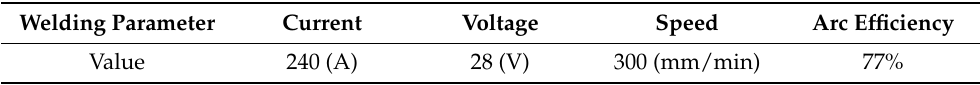
Figure 3. Geometrical configuration and boundary conditions. Table 2. Welding parameters.